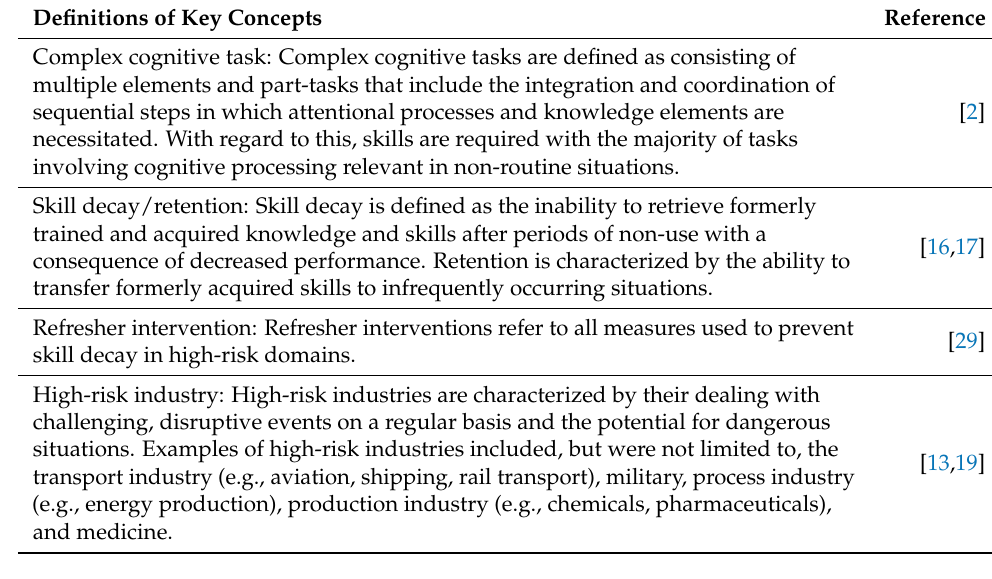
Table 2. Definitions of key concepts for inclusion within the scoping